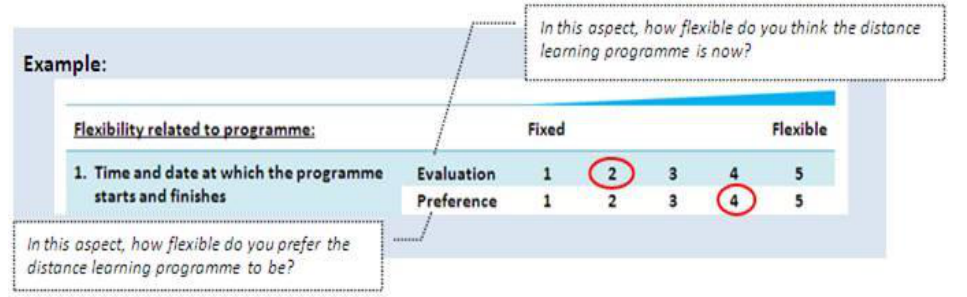
Figure 1 Questionnaire instructions for indicating levels of flexibility Findings and discussion